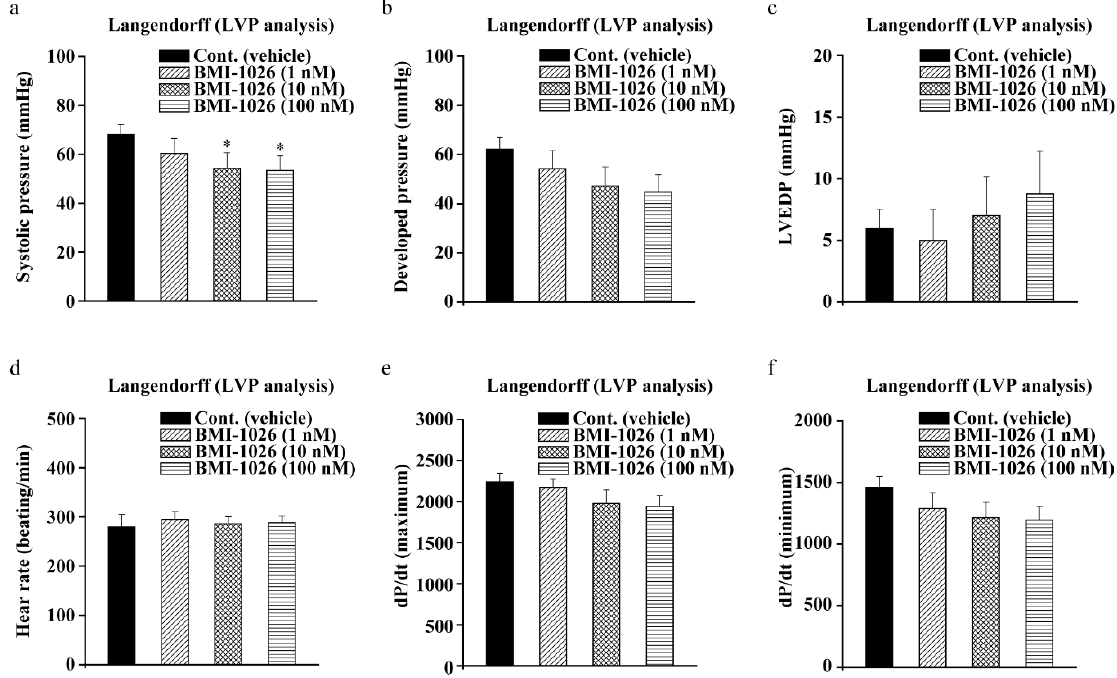
Figure 6. Assessment of electrophysiological safety of BMI-1026 in rats by left ventricular pressure (LVP) analysis. ( a – f ) All experiments were measured using rat LVP analysis. ( a ) Effect of BMI-1026 on left ventricular end-systolic pressure. ( b ) Effect of BMI-1026 on left ventricular pressure development. ( c ) Effect of BMI-1026 on left ventricular end-diastolic pressure. ( d ) Effect of BMI-1026 on heart rate. ( e – f ) Effect of BMI-1026 on ventricular contractility force. Significant differences were assessed by unpaired t -test at * p < 0.05. Cont., control; LVEDP, left ventricular end-diastolic pressure.